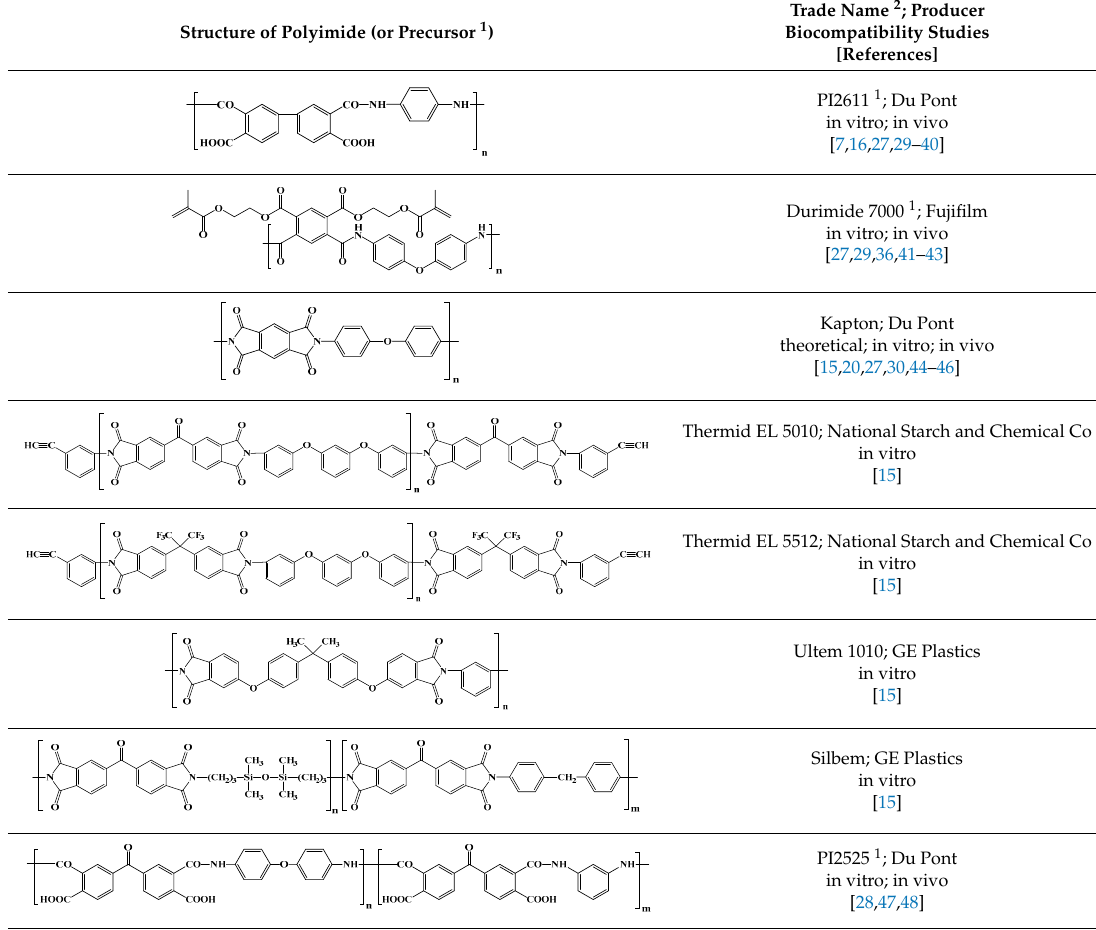
Table 1. Structure, trade name, and producer of commercial polyimides (or precursors) tested for their biocompatibility.